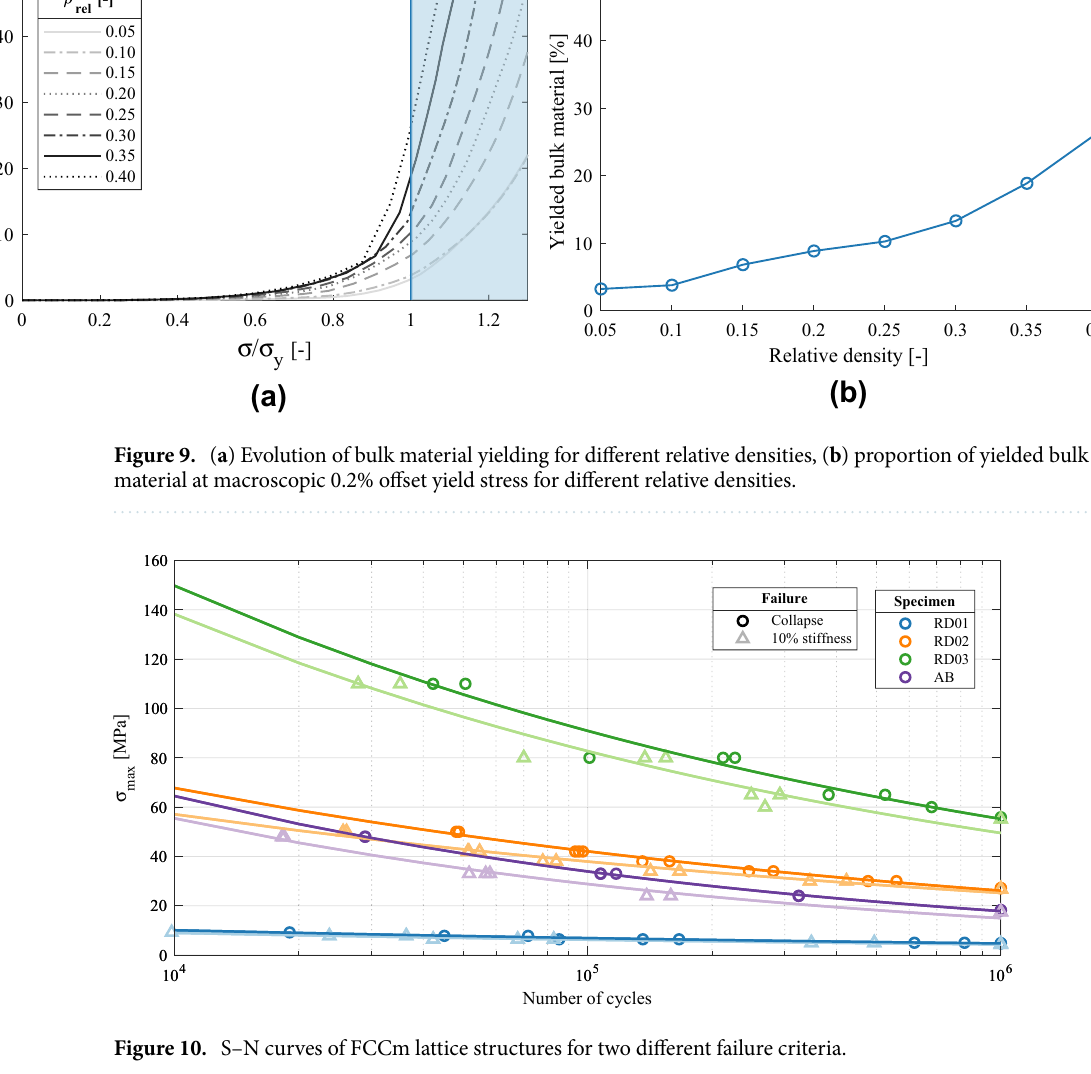
Figure 9b indicates the percentage of the yielded volume of each structure at the macroscopic yield stress level corresponding to the 0.2% offset stress. As the relative density increases, the proportion of regions with plastic